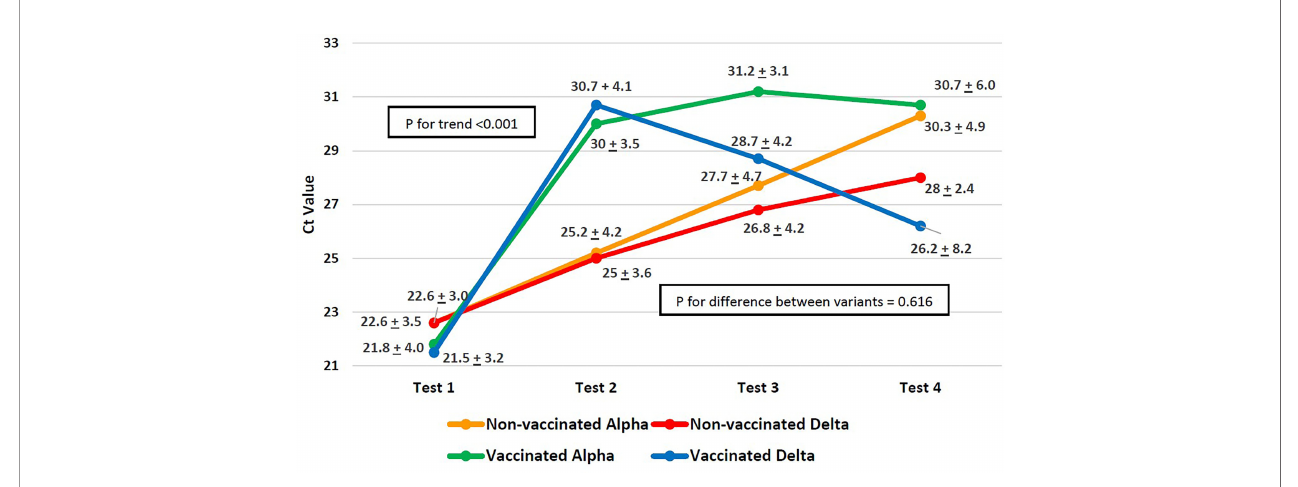
FIGURE 1 | Progression of PCR cycle time (CT) values across SARS-CoV-2